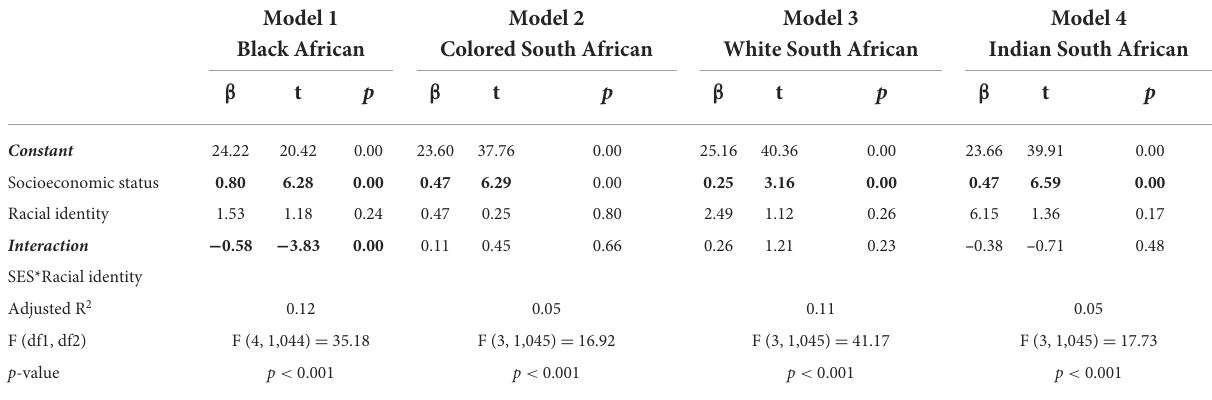
TABLE 4 Socioeconomic status and quality of life.